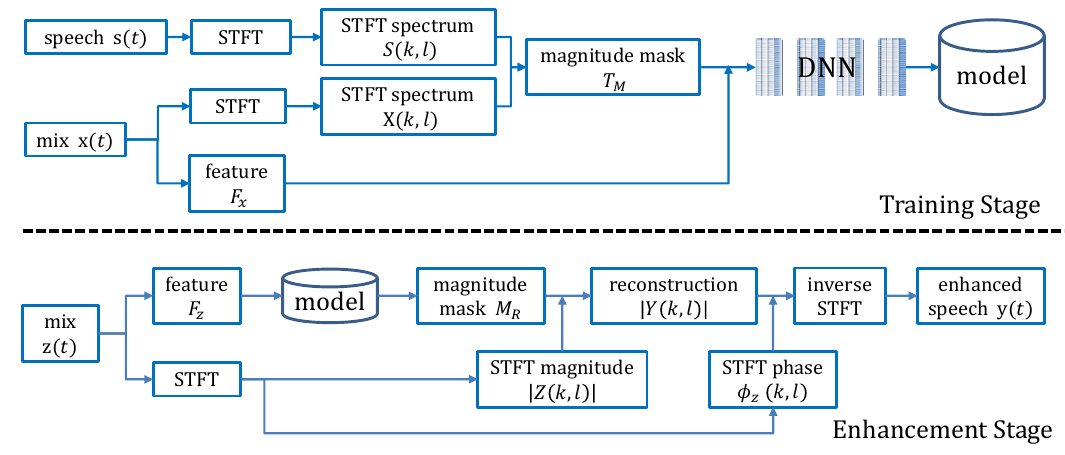
Figure 1. General scheme of existing deep neural network (DNN)-based speech enhancement method.